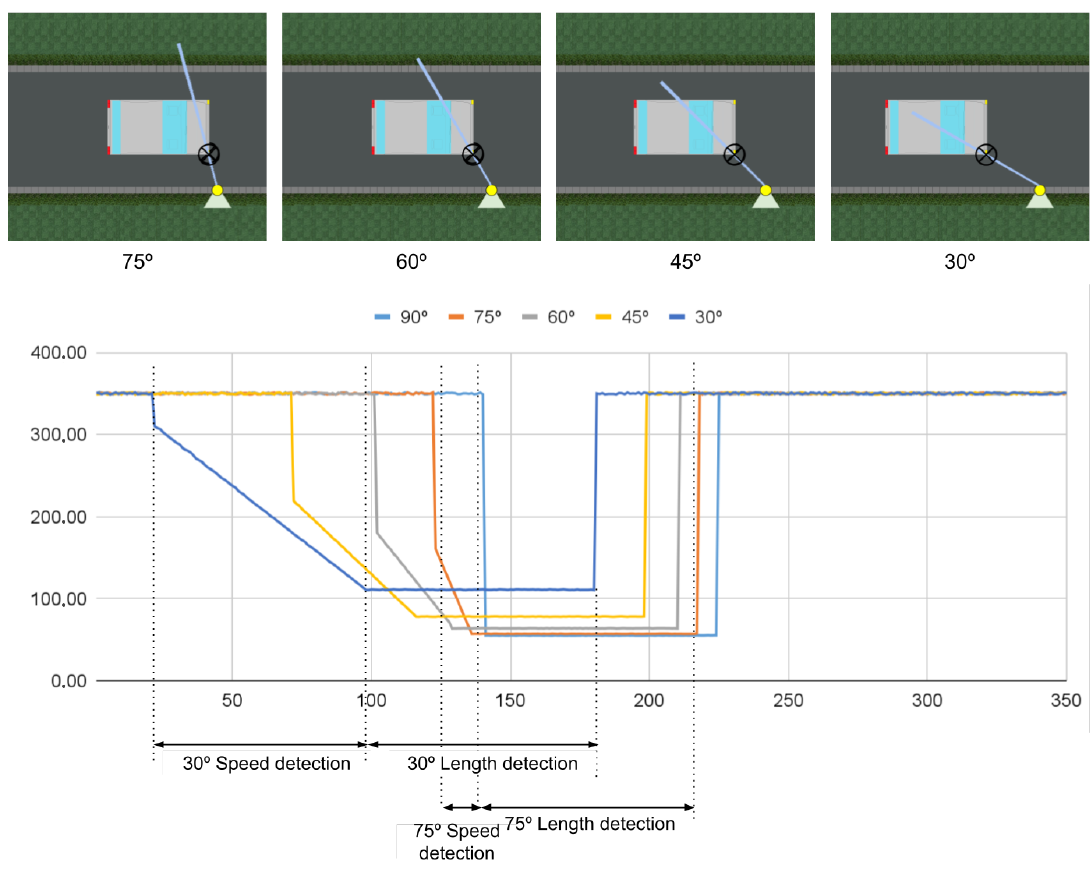
Figure 7. Selected configurations that provide a reasonably accurate estimation of vehicle characteris- tics: 90º, 75º, 60º, 45º, and 30º, and corresponding distances obtained